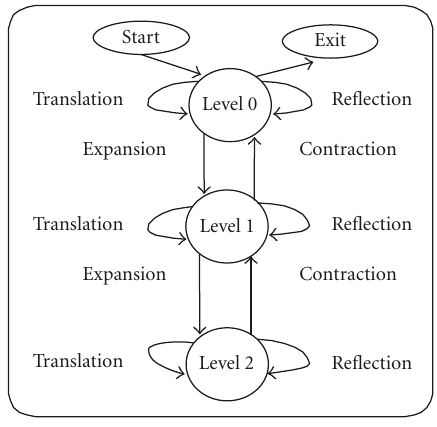
Figure 4: Relation between the FTS operations: reflection, expan- sion, translation, contraction, and triangle levels.